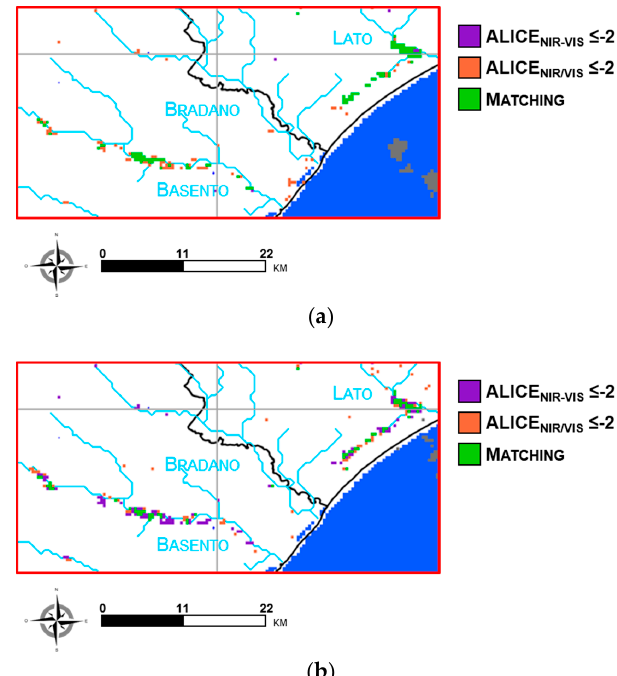
Figure 6. Anomalous pixels detected within the red box shown in Figure 1 by VIIRS-based RST- FLOOD on ( a ) 4 December 2013 at 12:10 GMT and ( b ) 5 December 2013 at 11:52 GMT using ALICE NIR-VIS (violet pixels) and ALICE NIR/VIS (orange pixels). In green, the pixels detected as anomalous by both indices are highlighted.